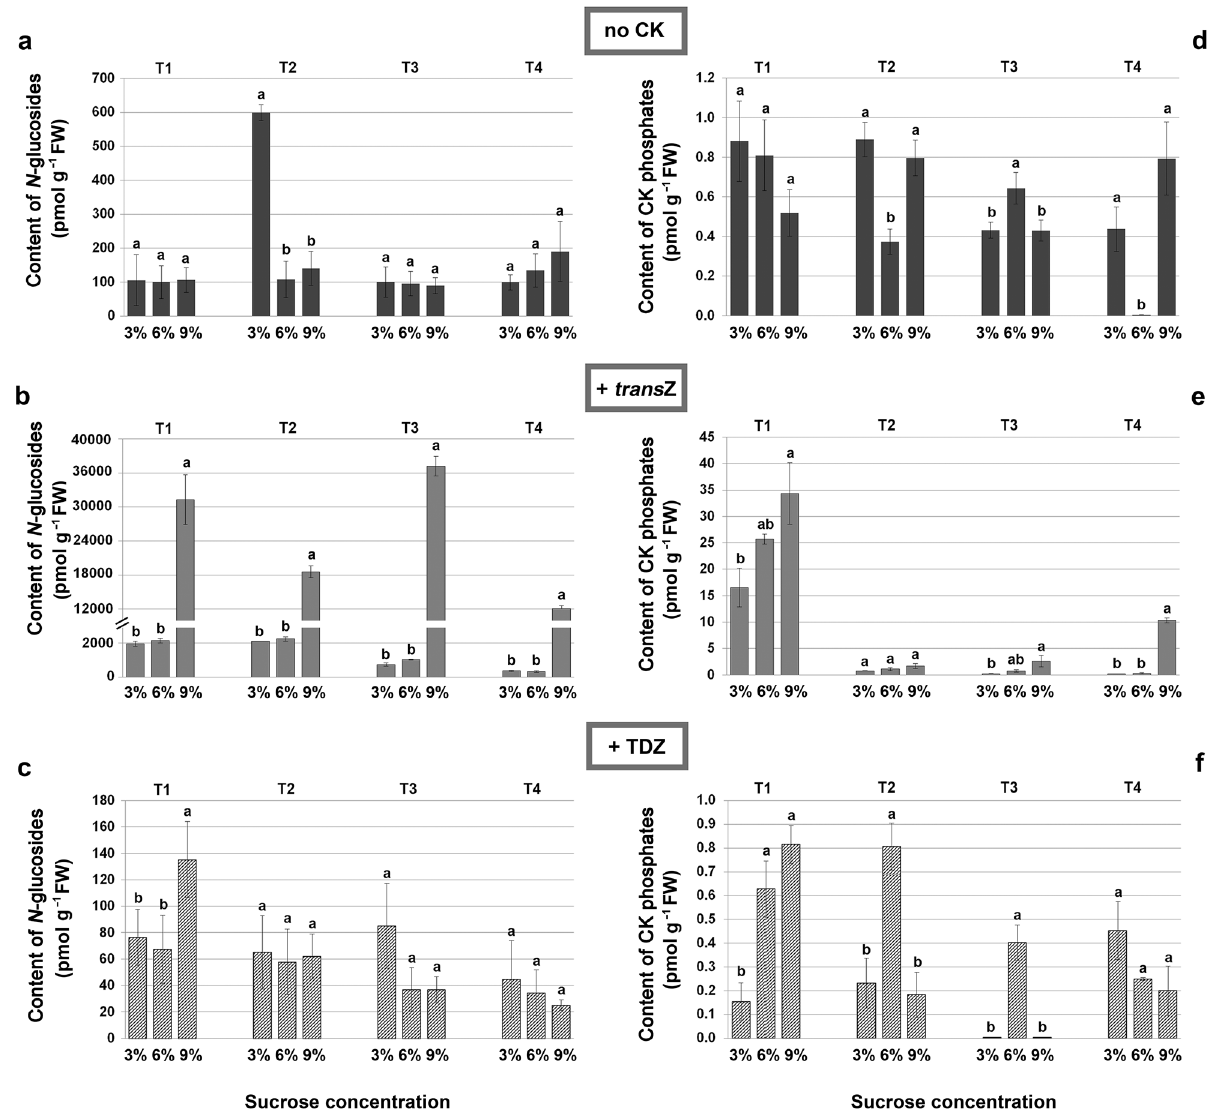
Figure 4. Contents (in pmol g −1 FW) of N -glucosides ( a – c ) and CK phosphates ( d – f ) in four developmental stages (T1–T4) during kohlrabi (cv. Vienna Purple) growth and de novo shoot organogenesis on media containing 3/6/9% sucrose without presence of cytokinins ( a , d ), with 2 mg L −1 trans Z ( b , e ) or with 2 mg L −1 TDZ ( c , f ). Data are shown as the mean ± SE (n = 3 independent biological replicates). Means marked with the same letter within each developmental stage of each treatment were not significantly different according to the LSD post-hoc test, P ≤ 0.05. trans Z: trans -zeatin; TDZ: